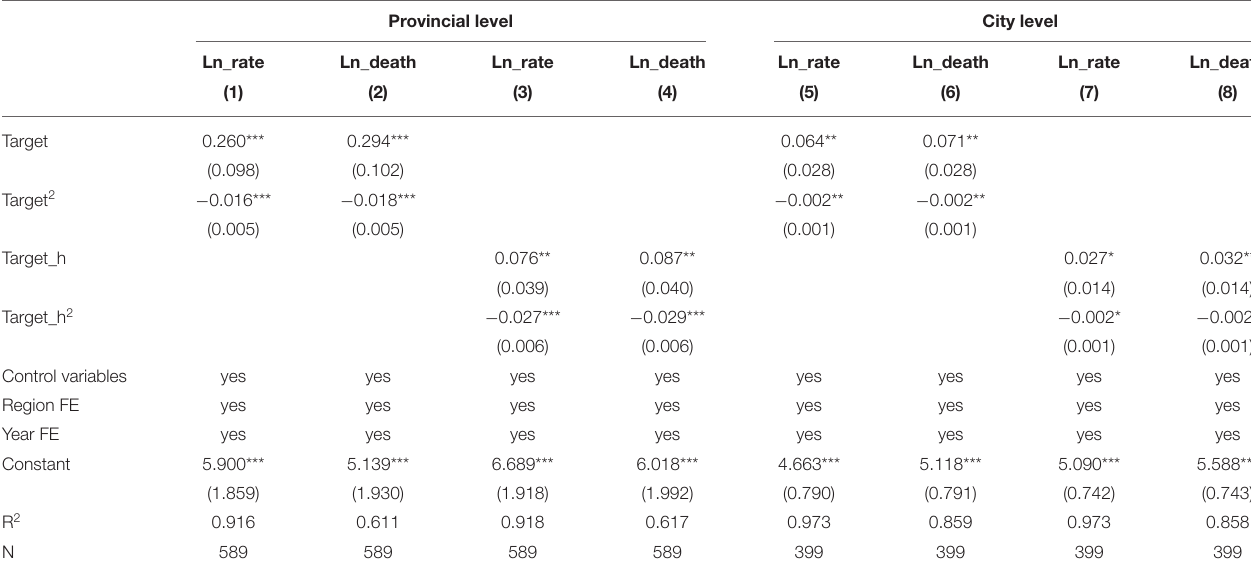
TABLE 5 | Robustness tests: change measurement method of economic growth target